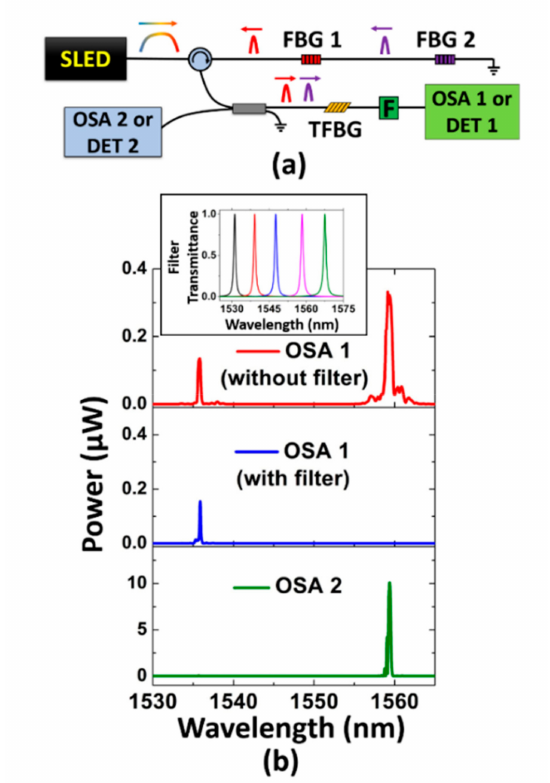
Figure 2. ( a ) Sensor setup. SLED: superluminescent light-emitting diode; OSA: optical spectrum analyzer; DET: photodetector; F: tunable spectral filter. ( b ) Spectra measured in OSA 1 (without and with the optical filter: red and blue lines, respectively) and in OSA 2 (green line). Inset shows the transmittance of the filter, which can be tuned